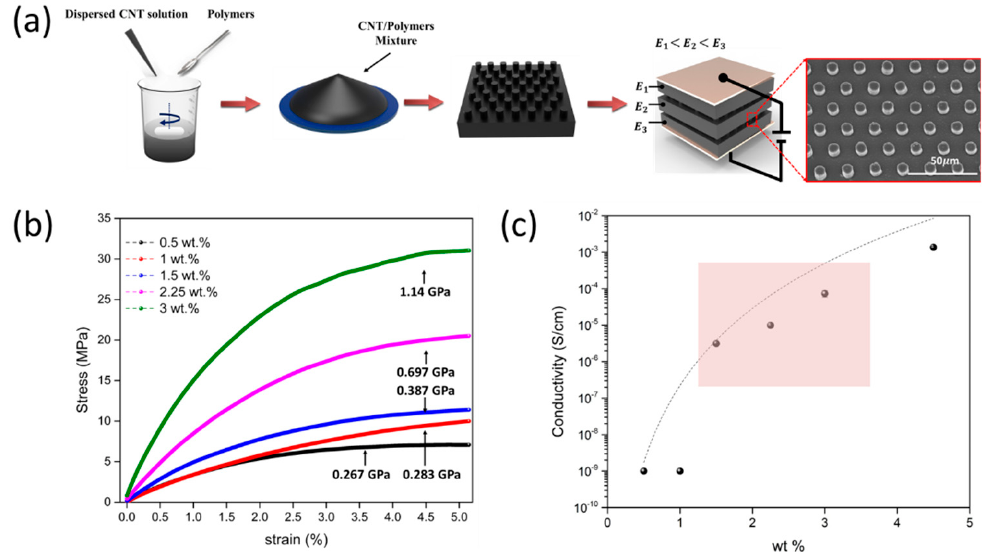
Figure 1. Conductive multilayer composites with modulus gradient ( E 1 , E 2 , and E 3 ) and stress-concentrating geometries ( a ) Schematic of the fabrication procedure used to produce the PVA/pNIPAM/SWCNTs composite with stress-concentrating geometries (inset SEM image of the composite shows a micro-circular structure for the stress-concentrating geometries between the composite layers (scale bar: 20 μm )) ( b ) Elastic modulus is estimated by considering the stress–strain curve of composites with different CNTs wt % ( c ) Electrical conductivity with increasing wt % of CNTs (shaded box represents the optimum conductivity of the sensor design)